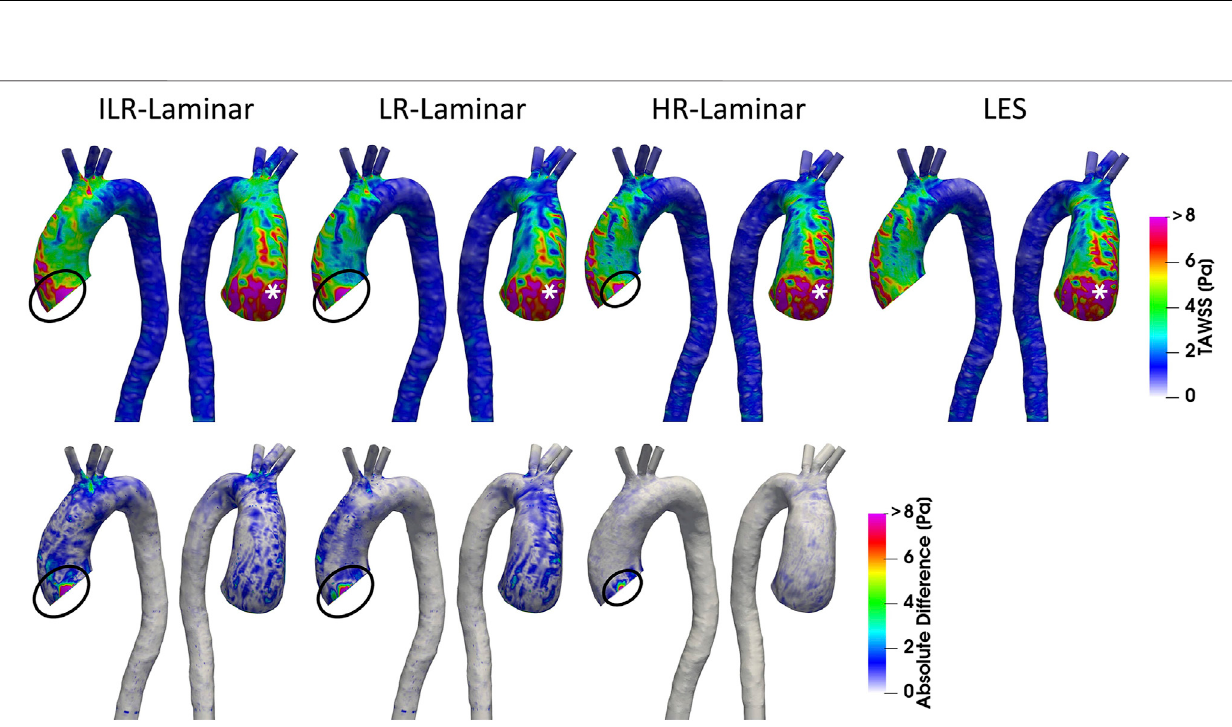
Frontiers in Bioengineering and Biotechnology |